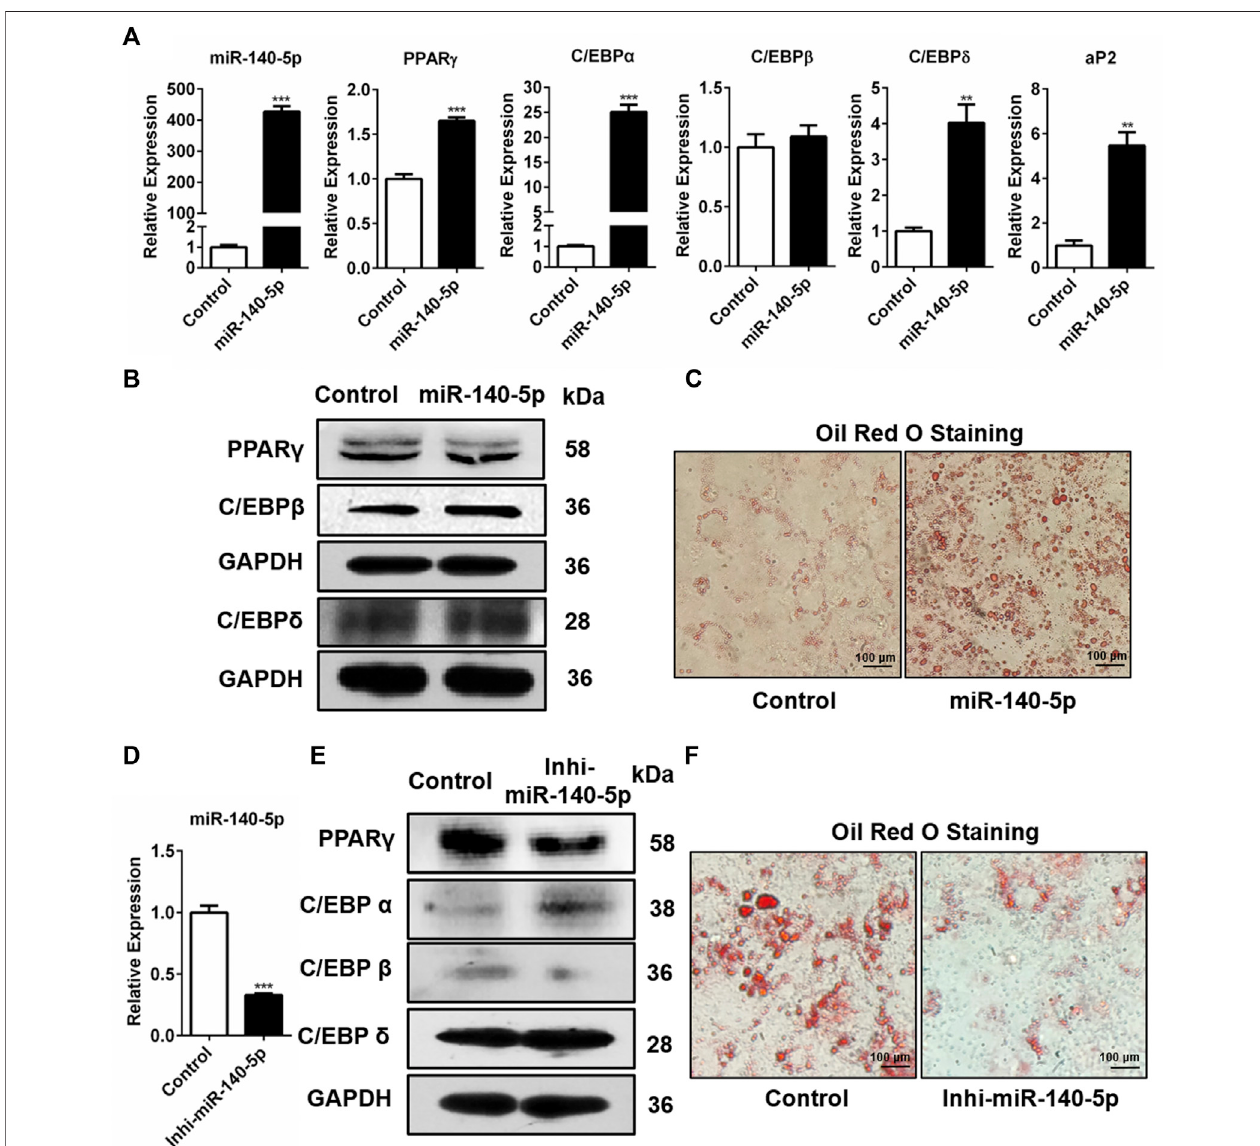
FIGURE 2 | Adipogenesis regulation via miR-140-5p as the adipogenic factor. (A) Expression levels of miR-140-5p and adipogenic genes after transient transfectionwithnegativecontrolmimics(Control)ormiR-140-5pmimicsin3T3-L1cellsbasedonqRT-PCRanalysis. (B) Westernblotassessmentofexpressionlevelof adipogenesis-linkedgenesafter 3T3-L1cellsweretransfected withmiR-140-5p mimics,aswellascontrolmimics. (C) Oilred Ostainingof3T3-L1cellsincelltransfects of miR-140-5p mimics and control mimics (100-fold magni fi cation). (D) Expression levels of miR-140-5p in 3T3-L1 preadipocytes transfected with miR-140-5p inhibitors (Inhi-miR-140-5p) and negative control (Control) based on qRT-PCR analysis. (E) Adipogenesis-linked gene protein content in 3T3-L1 cell transfects of miR- 140-5p inhibitor or control inhibitor. (F) Oil red O staining of preadipocytes — 3T3-L1 in the miR-140-5p inhibitor transfection group (Inhi-miR-140-5p) and control group (100-fold magni fi